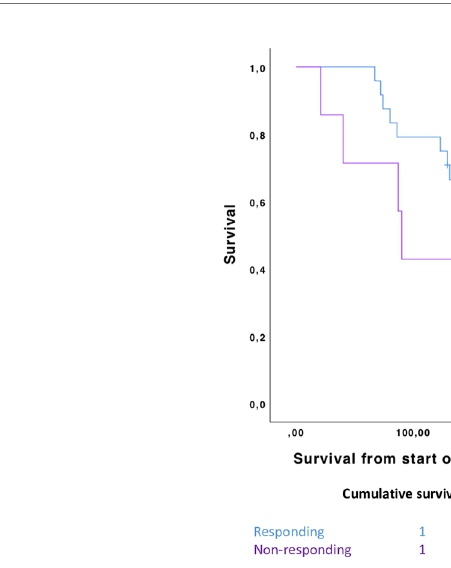
TABLE 2 | Global clinical bene fi ts following re-irradiation (re-RT) of all patients ( n = 31; Mann – Whitney U test p -value = 0.671) and the detailed clinical bene fi ts of well- documented patients ( n = 25) grouped according to the re-RT dose given (<20 Gy versus ≥ 20 Gy). Re-RT dose given (Gy) Clinical bene fi ts < 20 ( n = 14)